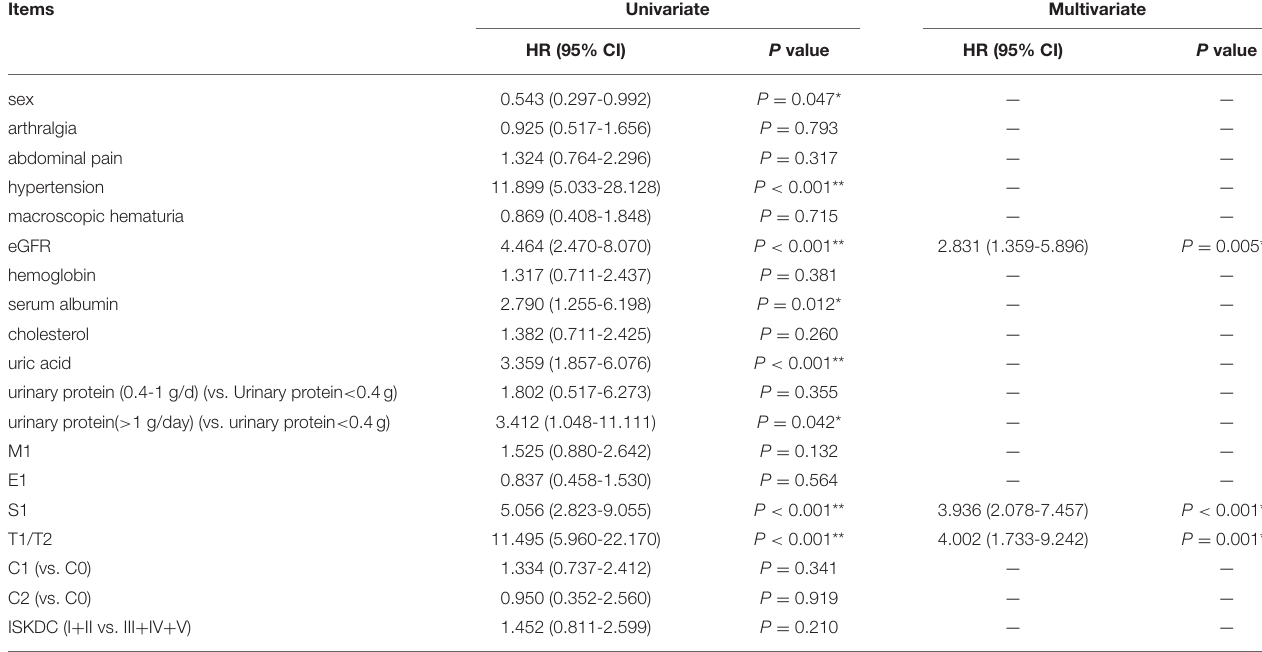
TABLE 4 | Univariate and multivariate Cox regression analyses of factors associated with renal outcome.